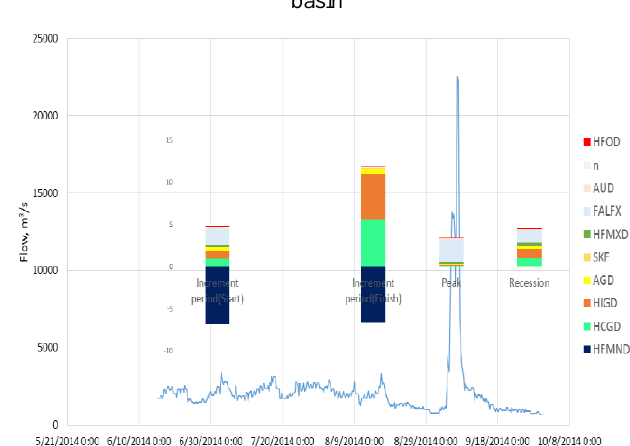
Fig. 10. Sensitivity indices of parameters variation at different flow regimes. Deterministic index for Chenab river basin